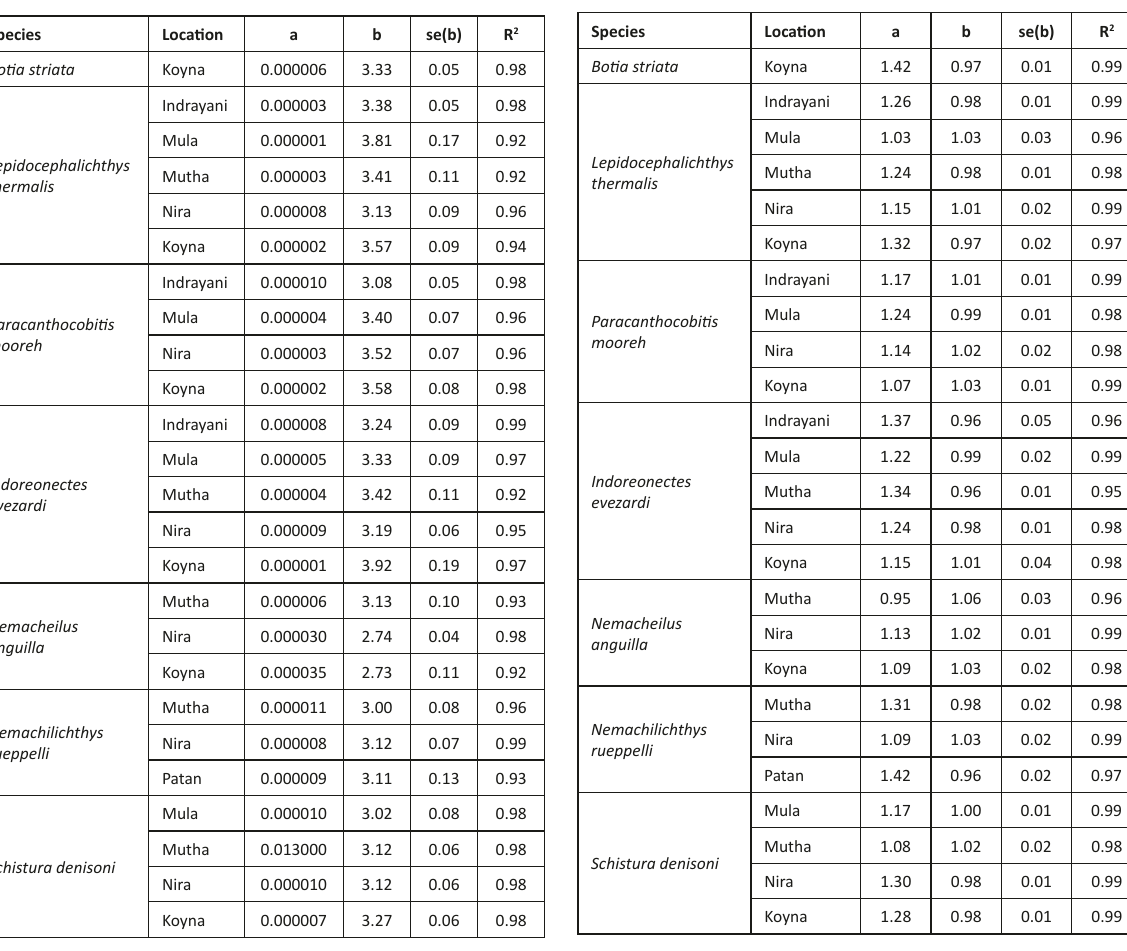
Table 3. Length-weight relationship for seven loach species from five rivers.